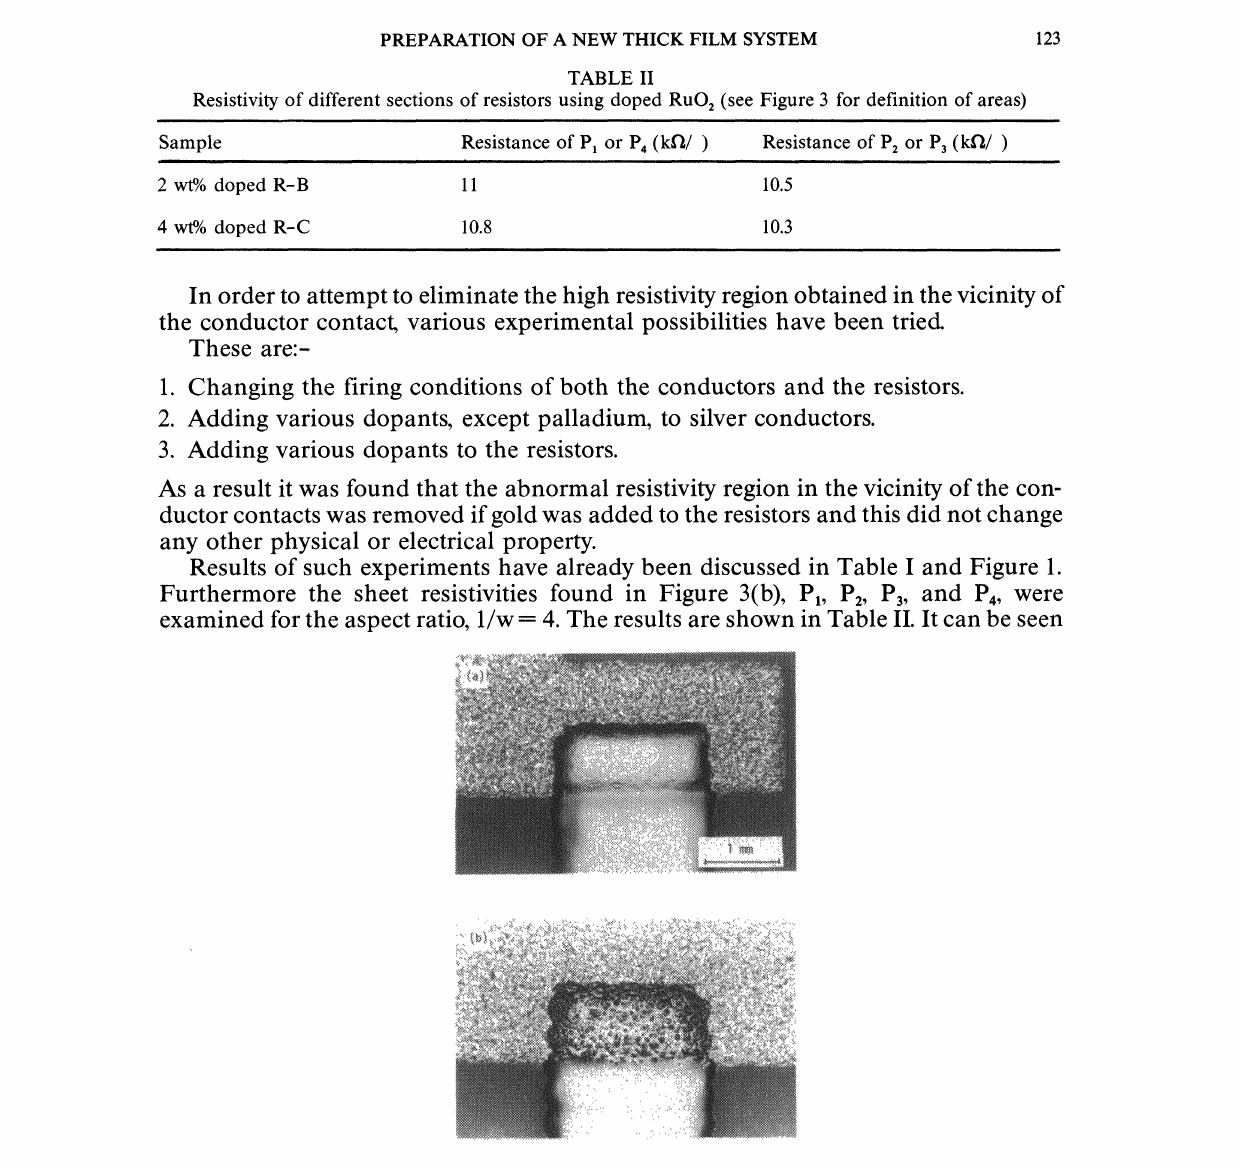
TABLE II Resistivity of different sections of resistors using doped RuOz (see Figure 3 for definition of areas)